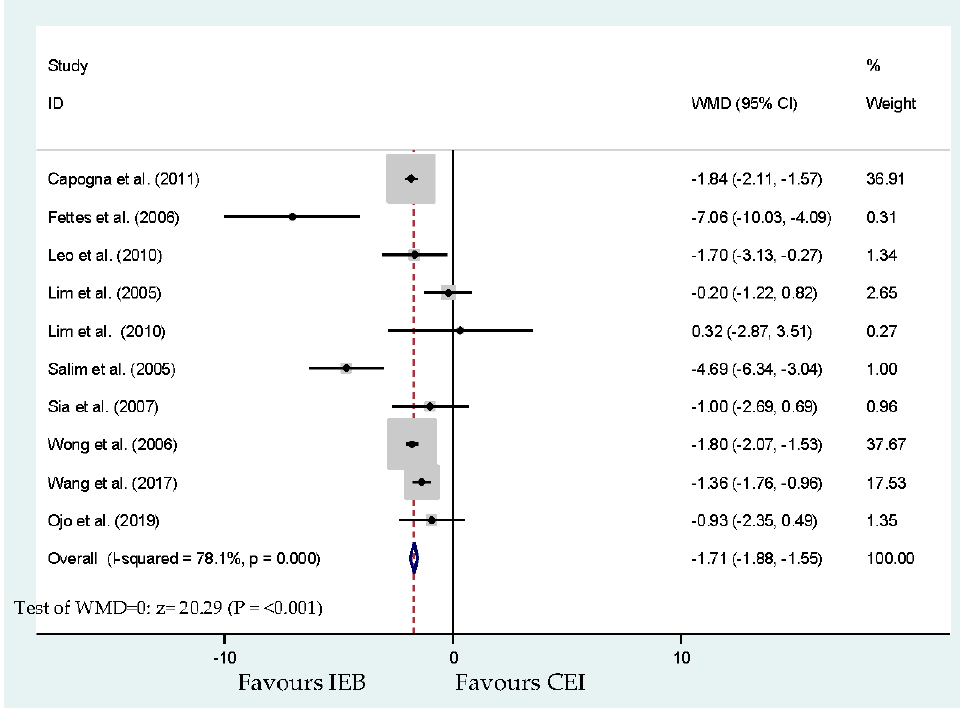
Figure 7. Overall effect for delivered dosage (milligrams per hour) of local anesthetic (bupivacaine equivalents).